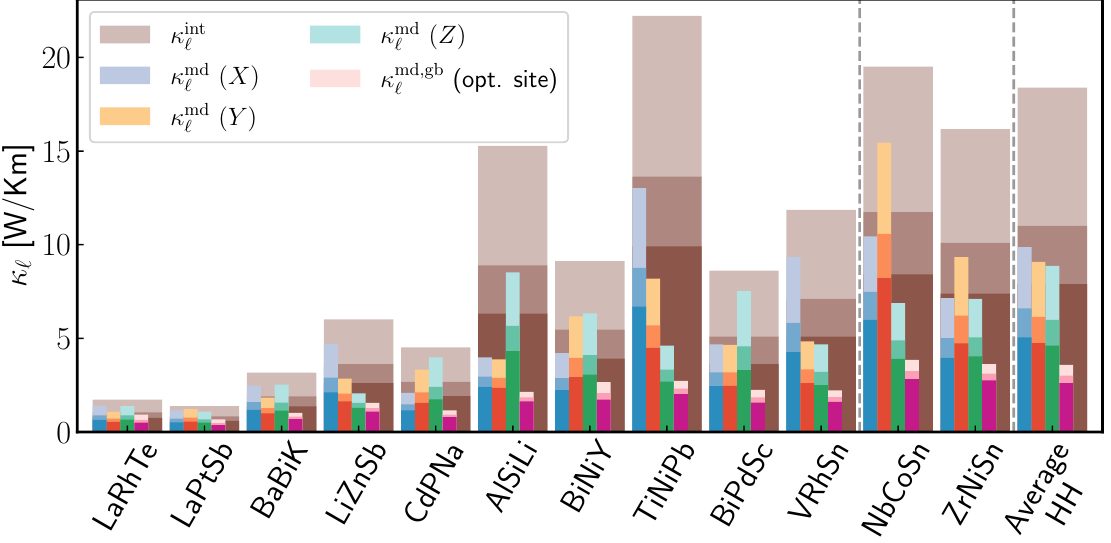
Figure 2. κ int κ md (cid:96) and (cid:96) for the 10 HH compounds with the lowest NbCoSn, ZrNiSn, and the average of all HH compounds as reference. Brown bars indicate the intrinsic LTC, while blue, orange, and green bars indicate the LTC with substitutions on X -, Y -, and Z -sites. Sub-bars of increasing color intensity indicate the LTC at 300 K, 500 K, and 700 K. Purple bars indicate κ md,gb